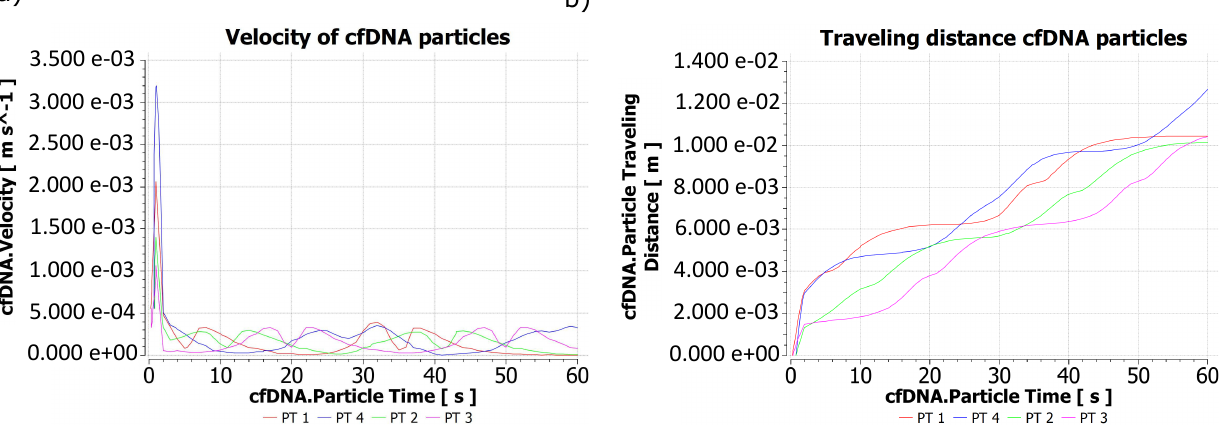
Figure 7. Behavior of the cfDNA particles during 60 s of simulation: ( a ) Velocity of cfDNA particles and ( b ) Traveling distance of cfDNA particles. When observing the line that represents each particle in different places of a colon sample, it is possible to identify the reason why some particles did not seem to have a linear traveled distance, since fluctuations in the velocity magnitude during the simulated time could slow down or accelerate each of the studied